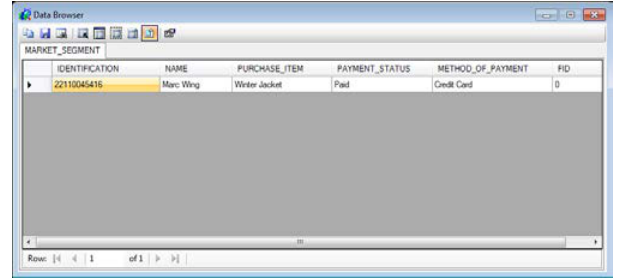
Figure 5. Retrieved record from database.